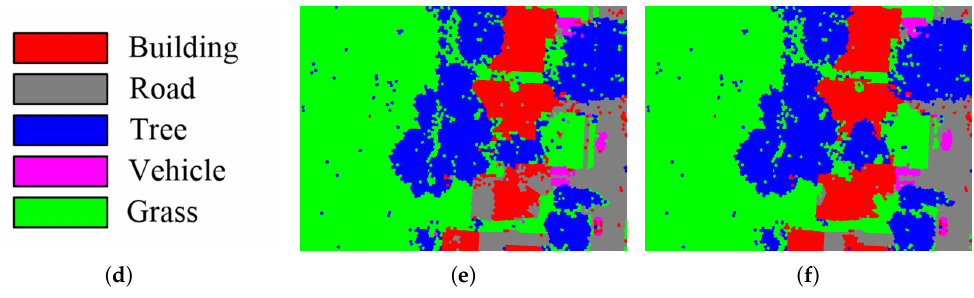
Figure 6. Classification maps generated from FloodNet-6651: ( a ) ground truth; ( b ) XGB + BT;